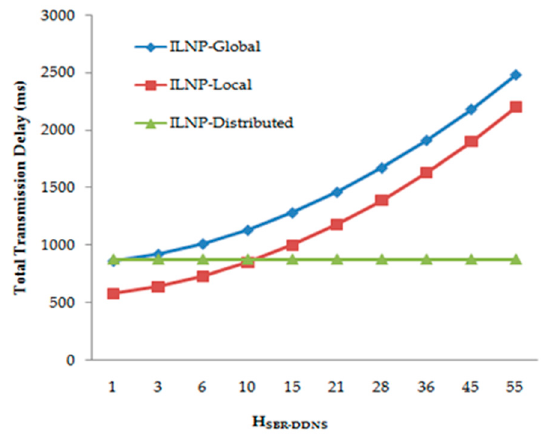
Figure 22. Impact of H AR-SBR on TTD.